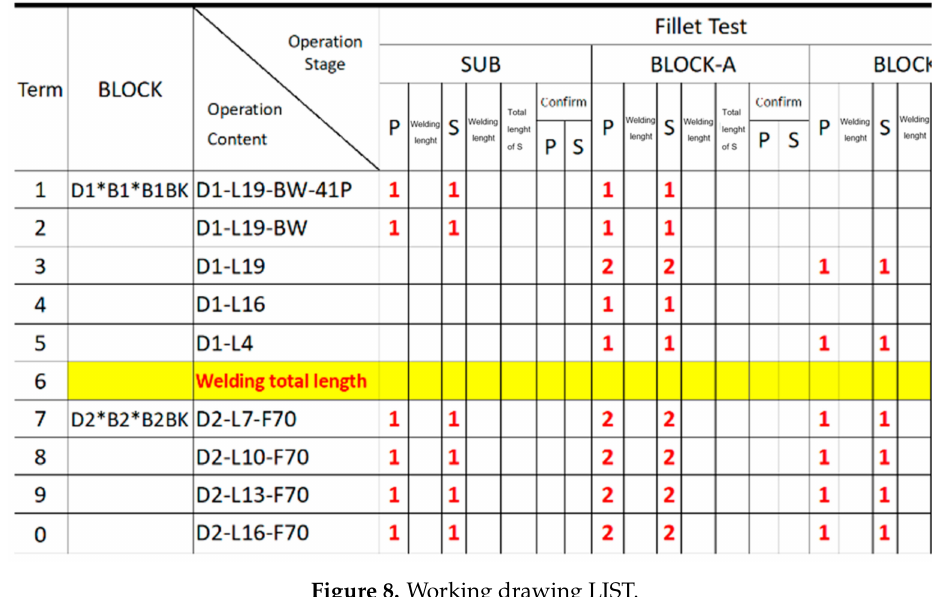
Figure 8. Working drawing LIST.